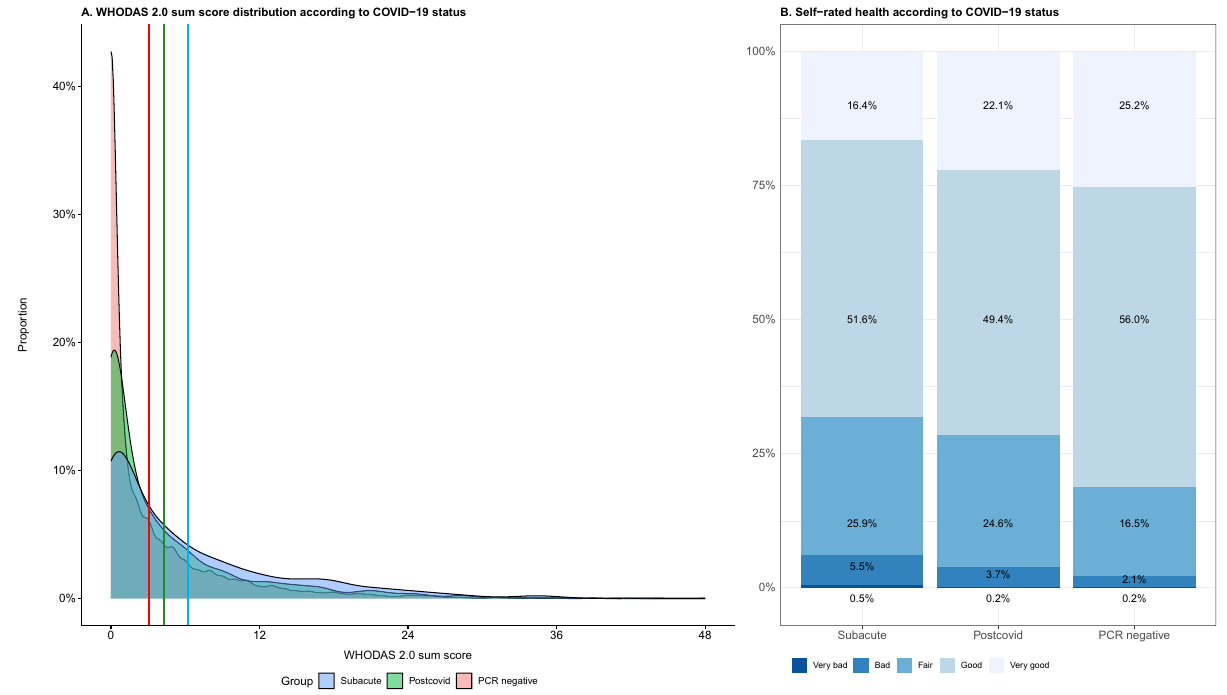
Figure 3. Distribution of WHODAS sum scores according to COVID-19 status. ( A ) Density plot of WHODAS 2.0 sum scores (range 0–48). Vertical axis presents proportion of participants with each WHODAS score (horizontal axis). Vertical lines represent means of PCR negative participants (red; mean 3.1), postcovid (green, mean 4.3) and subacute groups (blue, mean 6.2). ( B ) Proportions in each category of self-rated health, from very bad to very good, left to right: PCR subacute phase, postcovid phase and